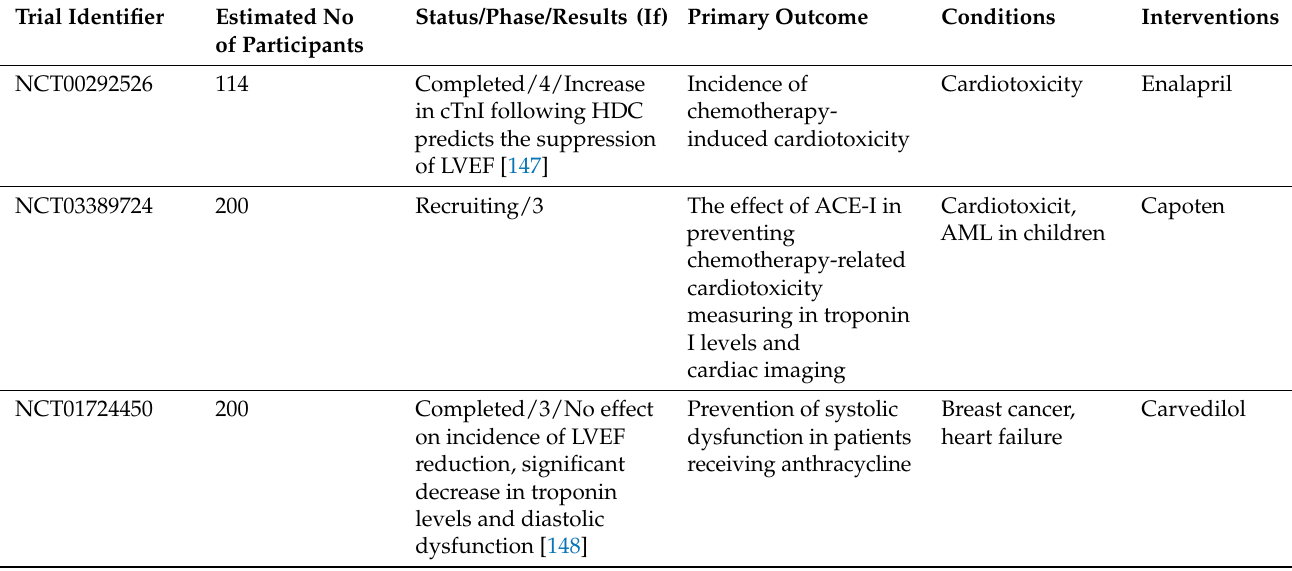
Table 5. Clinical trials on mitigating the cardiotoxicity induced by